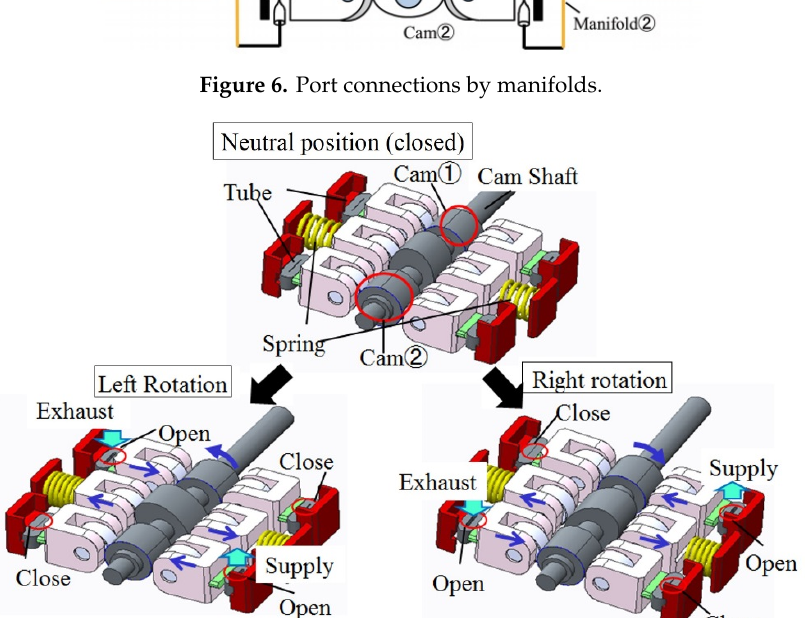
Figure 7. Structure model of the developed pinch-type valve (Cam ① and ② are shaped as shown in Figure 8).